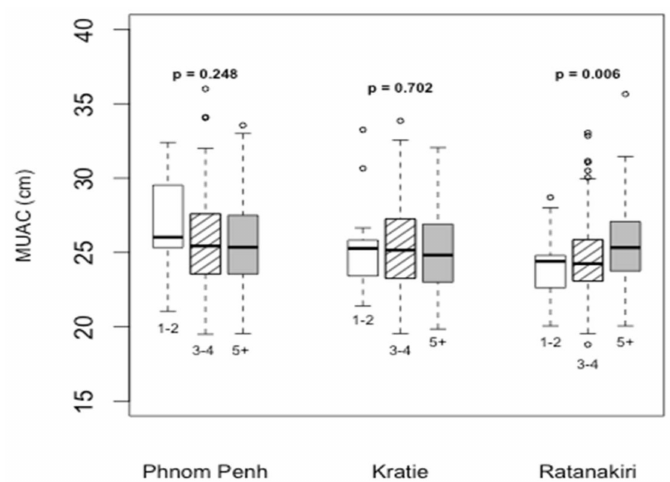
Figure 2. Comparison of pregnant women’s MUAC (Middle Upper arm circumference) according to their dietary diversity score and regions. (Note: p < 0.05 shows a significant difference in the mean of MUAC within provinces between the 3 categories of WDDS (Women’s Dietary Diversity Score): (i) 1–2 food groups consumed; (ii) 3–4 food groups; (iii) above 4 food groups; ◦ : out